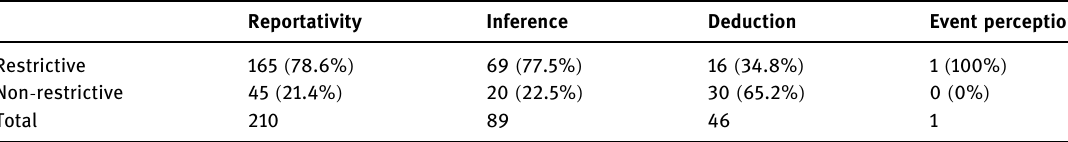
Table 7: Restrictiveness and evidentiality